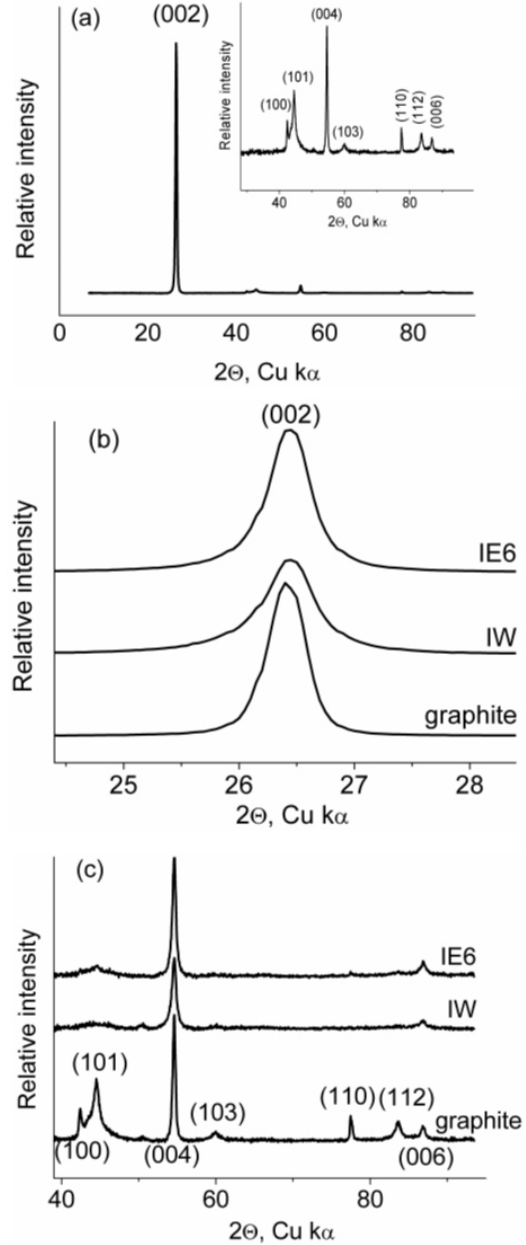
Figure 2. (a) XRD pattern of the starting graphite material (in the inset: the low-intensity peaks can be observed) and (b-c) samples made by different dispersion media (IW – water and IE6 – ethanol) with marked Miller indices